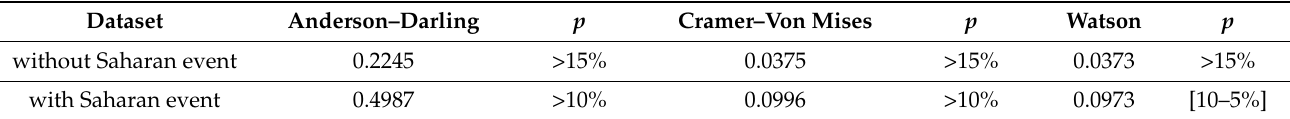
Table 1. Normality tests of ilr for the two considered datasets.